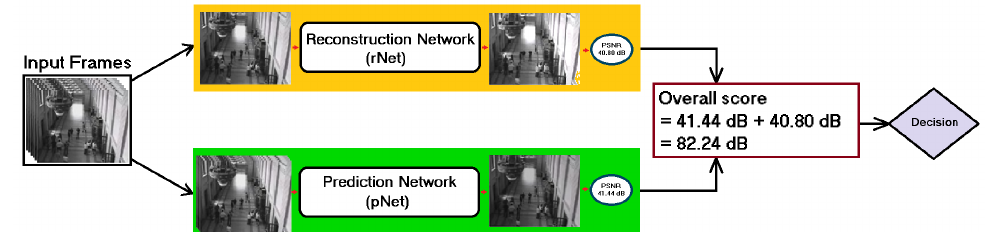
Figure 10. Simplified structure of